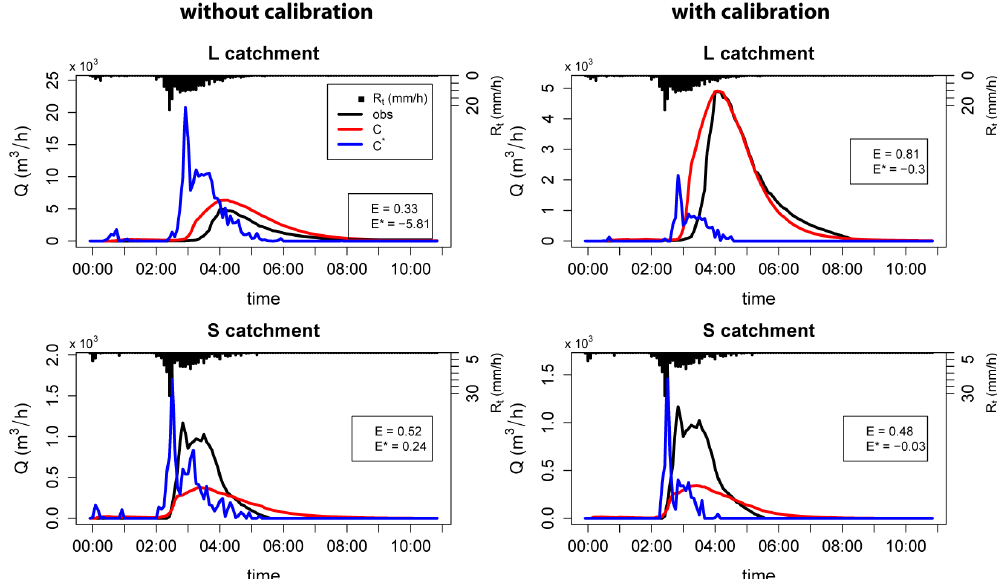
Fig. A4. Same as in Fig. A1, for an event on 8 September 2010. Note that observed discharge in the M catchment is not available for this